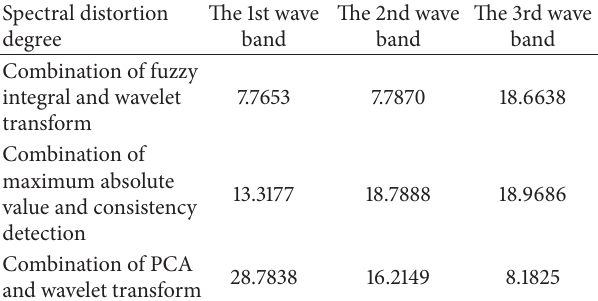
Table 7: Spectral distortion degree.